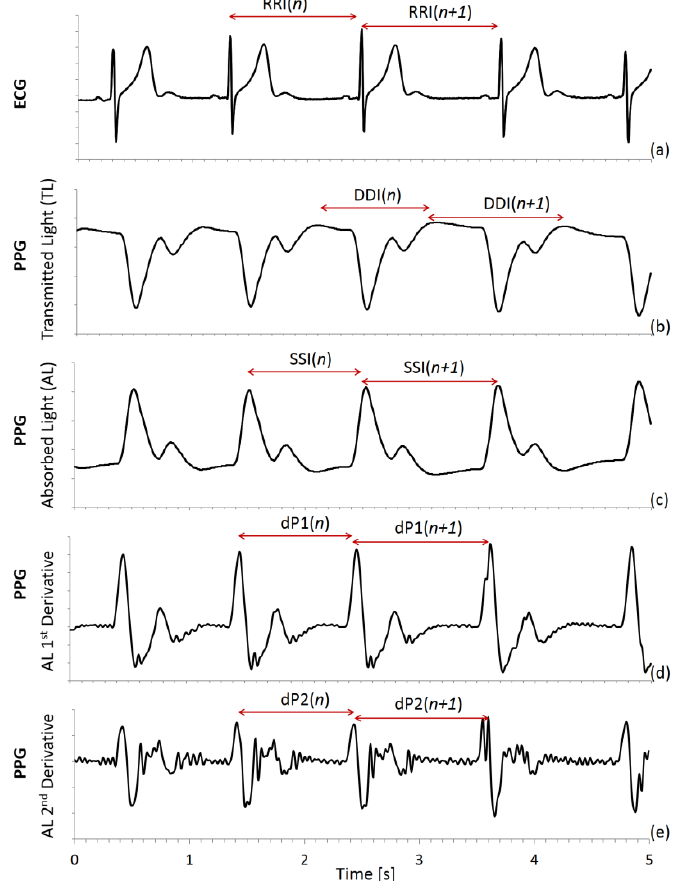
Figure 1. ECG and PPG tachograms. Derivative-and-threshold algorithms are applied to ( a ) ECG, ( b ) intensity of transmitted light (TL) on the finger PPG sensor, ( c ) absorbed light (AL = − TL), ( d ) AL 1st and ( e ) 2nd derivative. RRI is the reference; PPG tachograms are: DDI = interval between TL maxima; SSI = interval between AL maxima; dP1 = interval between maxima of AL 1st derivative; and dP2 = interval between maxima of AL 2nd